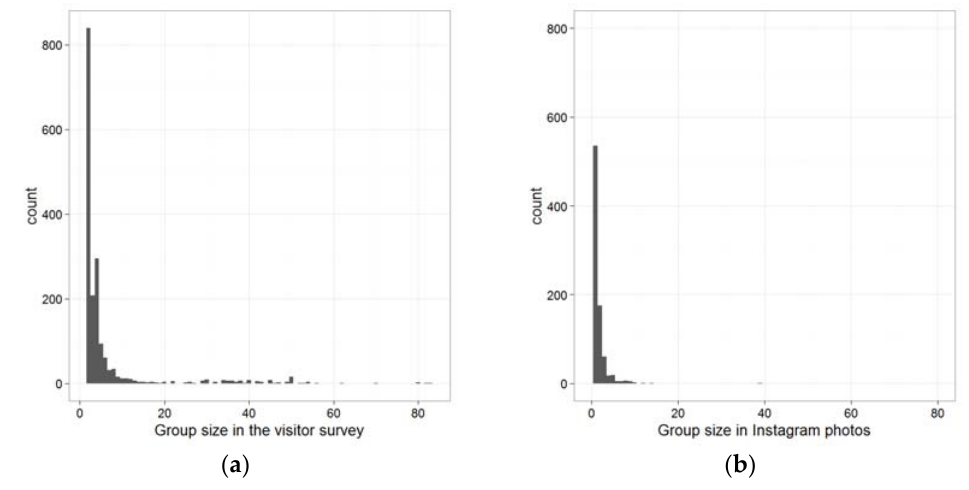
Figure 7. The group size based on ( a ) the survey and ( b ) interpreted from the Instagram images.